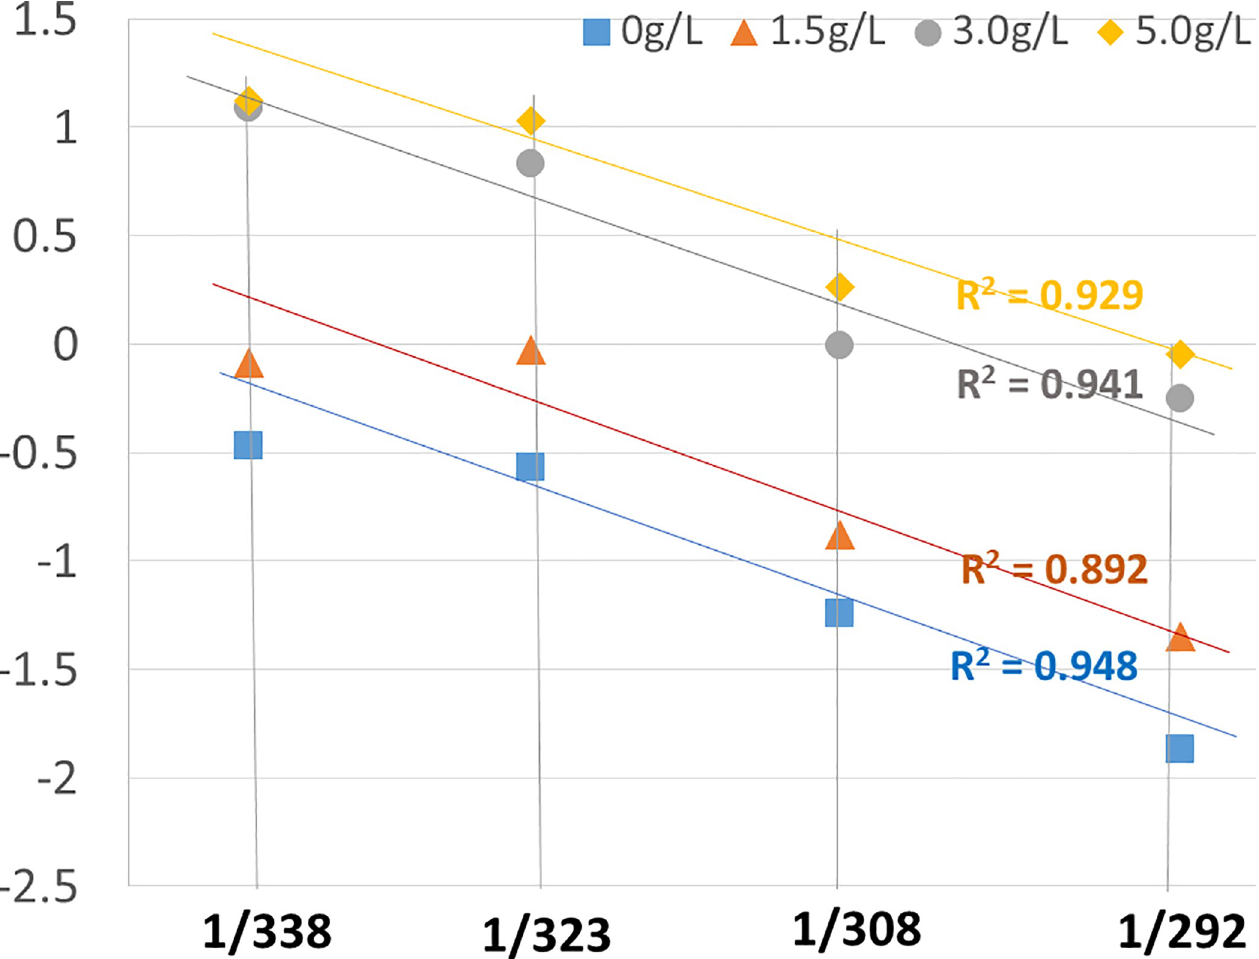
Fig 7. Relationship between μ